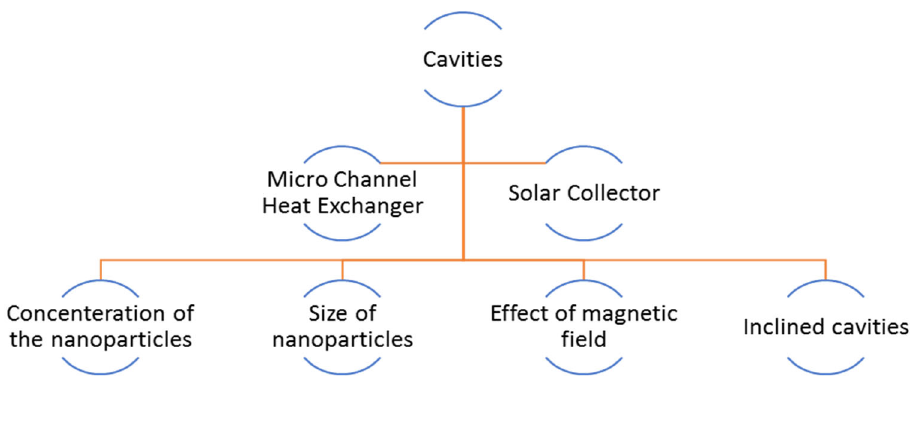
Figure 1. Flow chart of the review.